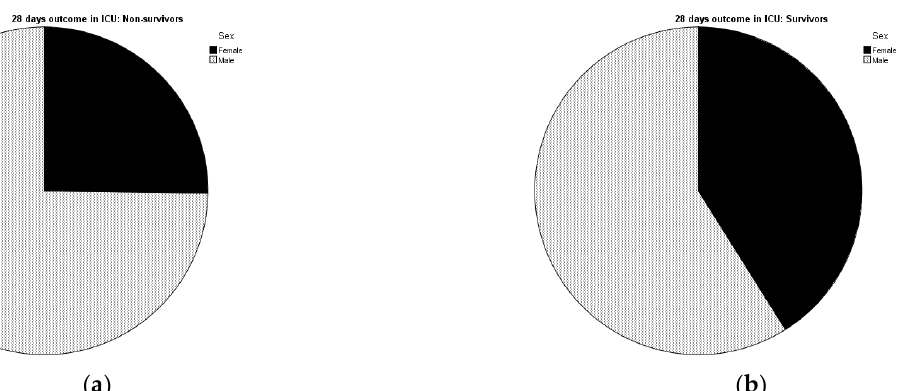
Figure 1. Pie charts showing percentage distribution of gender in group of ( a ) non-survivors and ( b ) survivors.